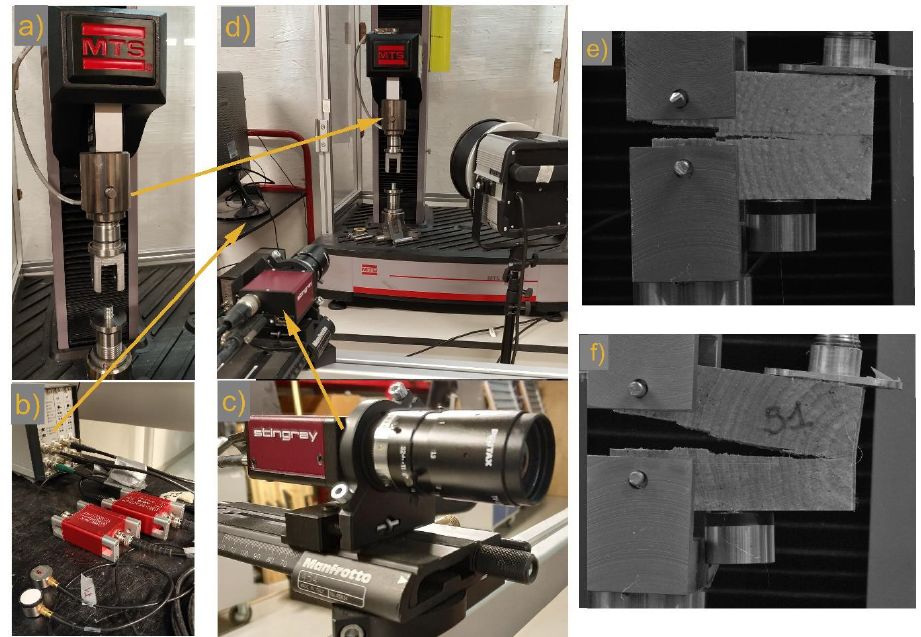
Figure 2. Experimental setup used to conduct the splitting tests on the pine and oak simil-CT samples.